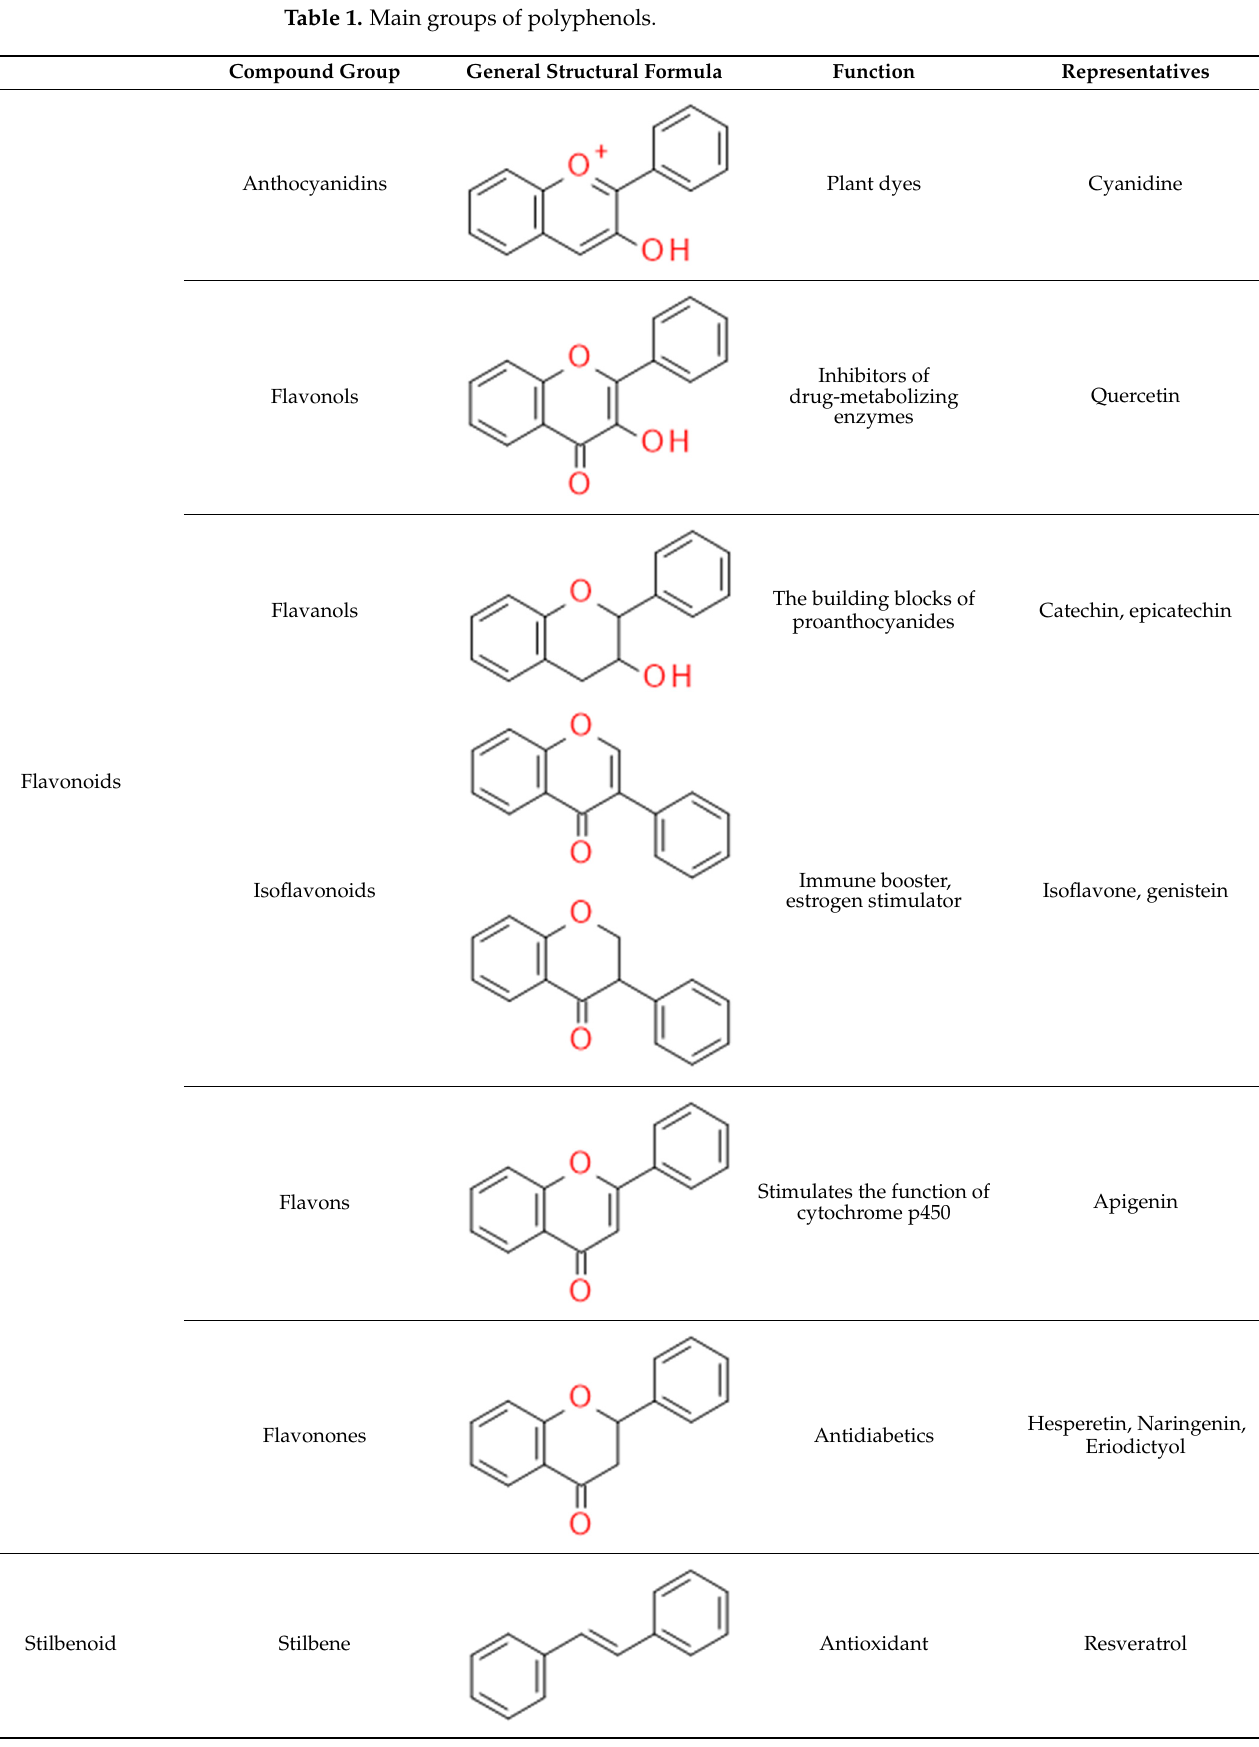
Figure 1. General structure of polyphenols. Table 1. Main groups of polyphenols.